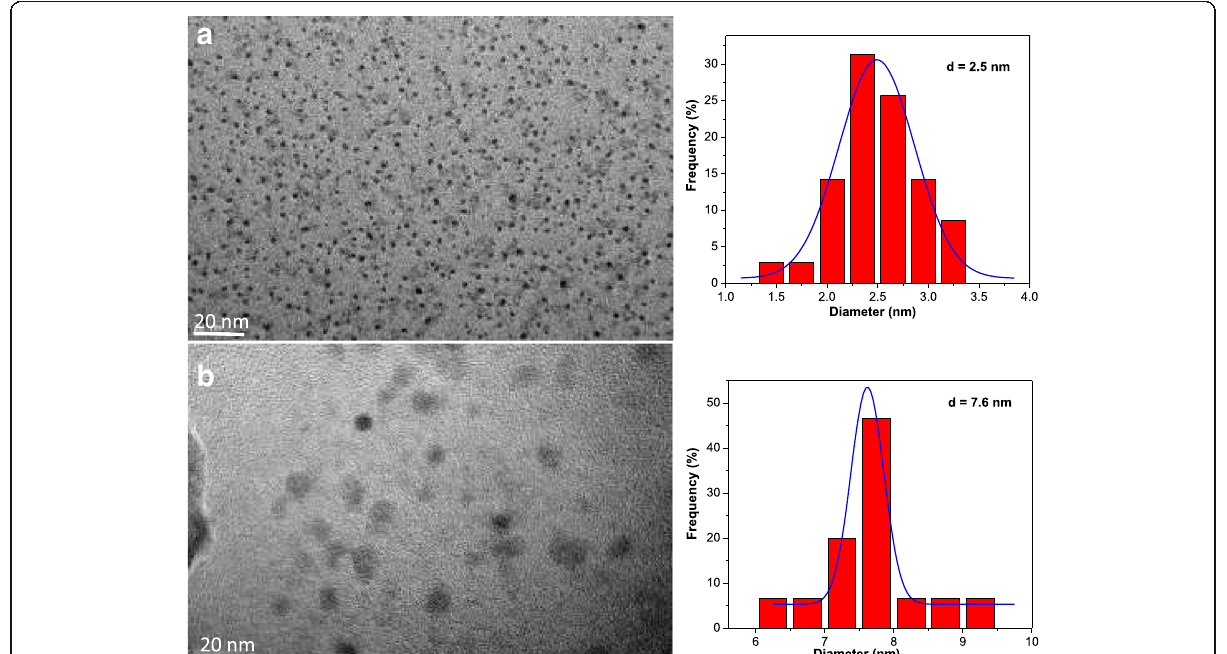
Fig. 1 TEM images (left) and corresponding size distribution histograms (right) of a CQDs and b